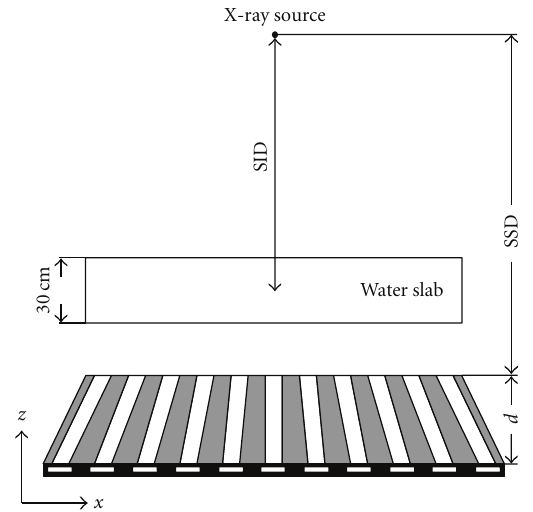
Figure 3: Schematic illustration of the geometry used when simulating the primary and scatter components of exit beam due to the presence of a